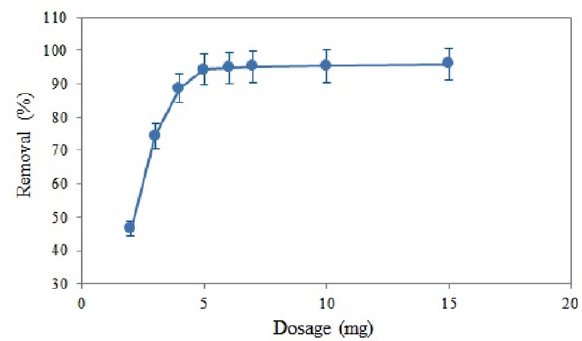
Figure 3. Effect of adsorbent dosage on MB adsorption by nanoze- olite L